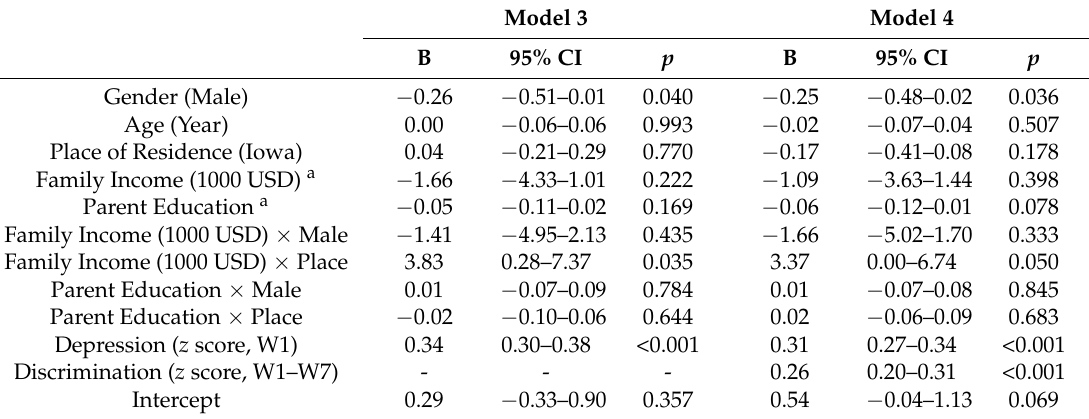
Table 4. Summary of linear regressions to test the interactive effects of place, socioeconomic status (SES), gender, and discrimination on average depressive symptoms over 18 years ( n =